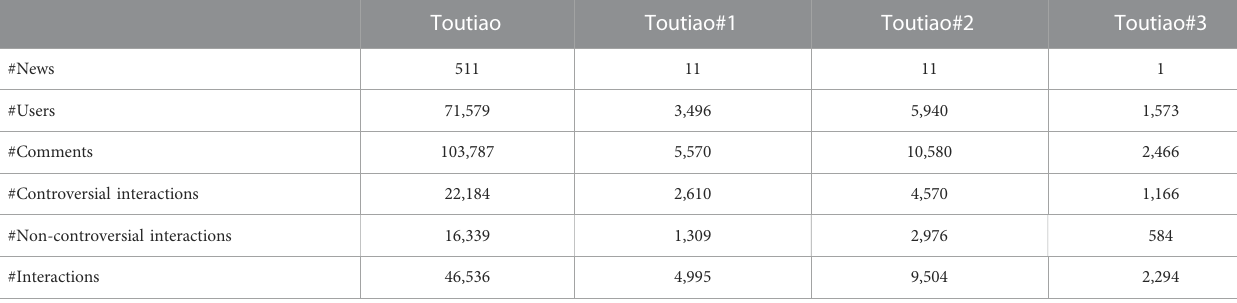
TABLE 1 Basic statistics of the Toutiao dataset and its subsets.